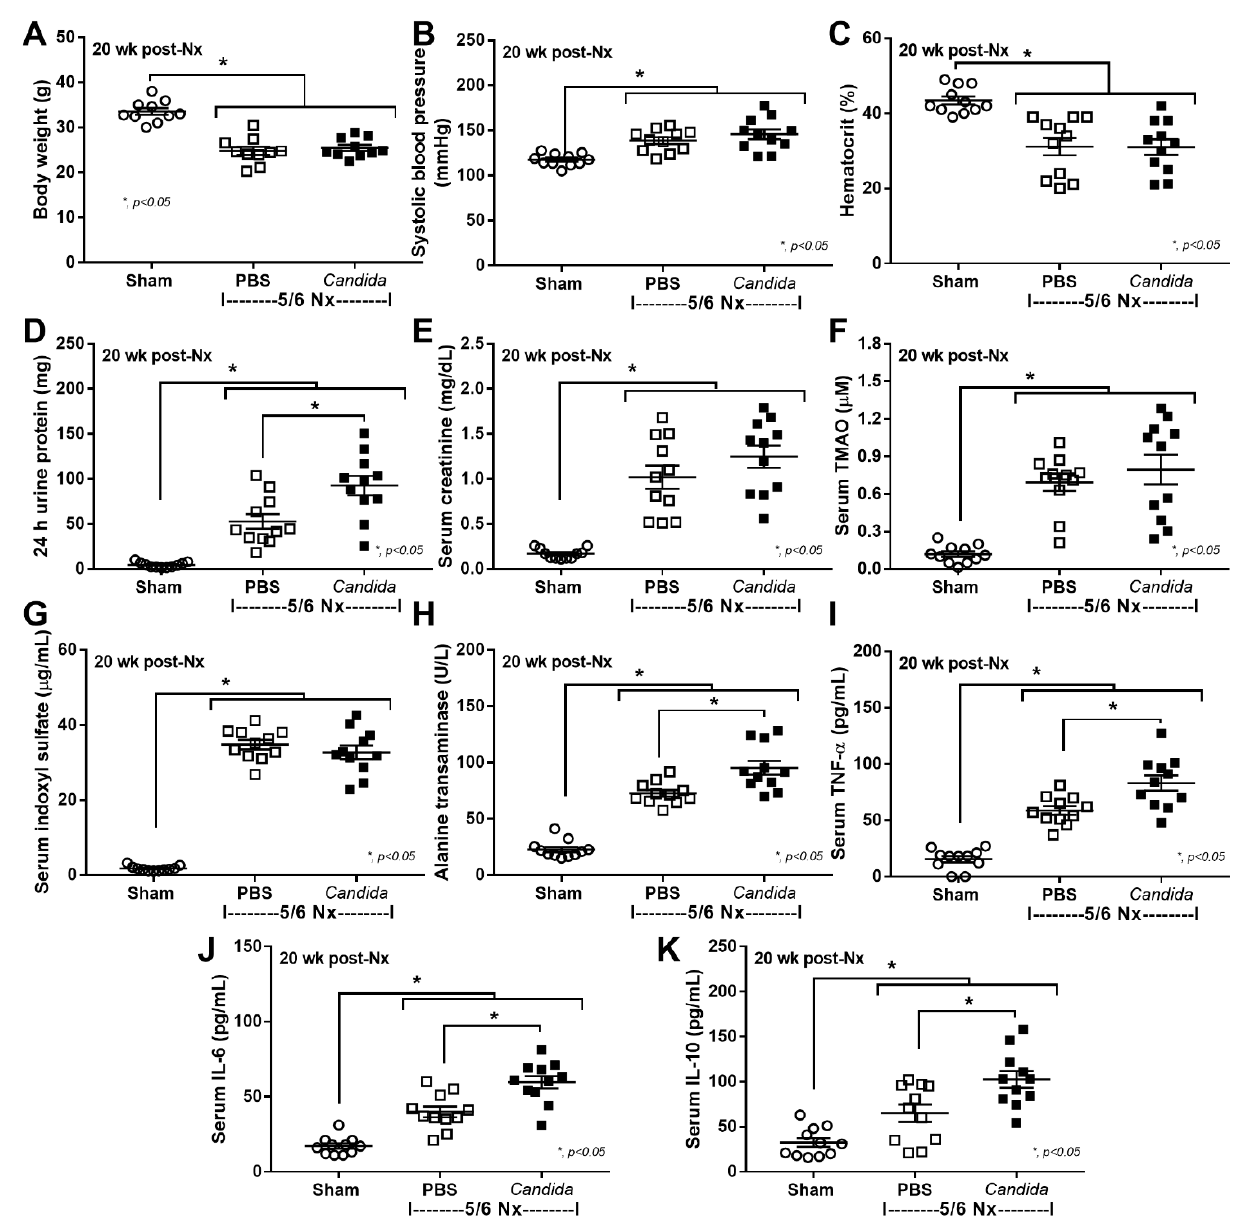
Figure 1. The characteristics of Sham control and 5/6 nephrectomized (5/6 Nx) mice with phosphate buffer solution (PBS) or Candida administration ( Candida ) at 20 weeks (wk) after right nephrectomy (20 week post Nx) (see method), as indicated by body weight ( A ), mean arterial pressure ( B ), hematocrit ( C ), renal function (24 h urine protein and serum creatinine) ( D , E ), serum gut-derived uremic toxins, including trimethylamine N-oxide (TMAO) and indoxyl sulfate ( F , G ), liver enzyme (alanine transaminase) ( H ), and serum cytokines (TNF- α , IL-6, and IL-10) ( I – K ) are demonstrated ( n = 11 / group).